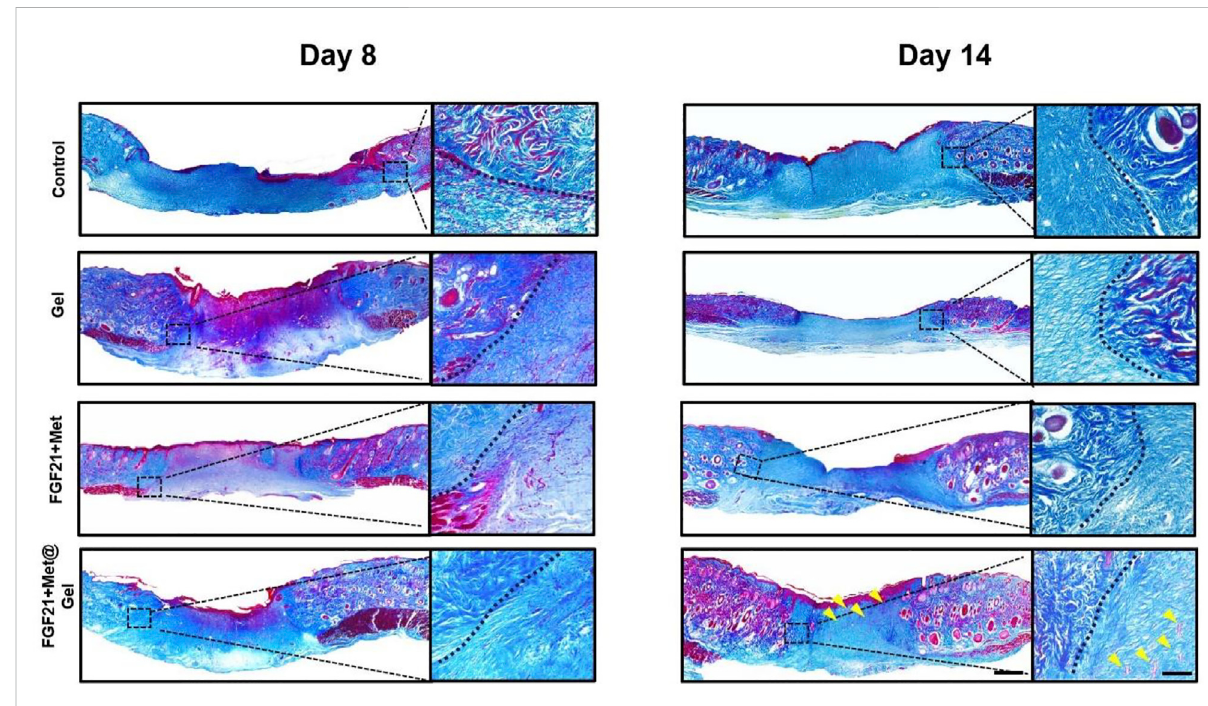
FIGURE 5 Representative images of Masson ’ s trichrome staining of skin tissues on days 8 and 14 (yellow arrows indicated the new regenerated follicles). The scale bars are 1000 μ m (left) and 250 μ m (right, magni fi ed